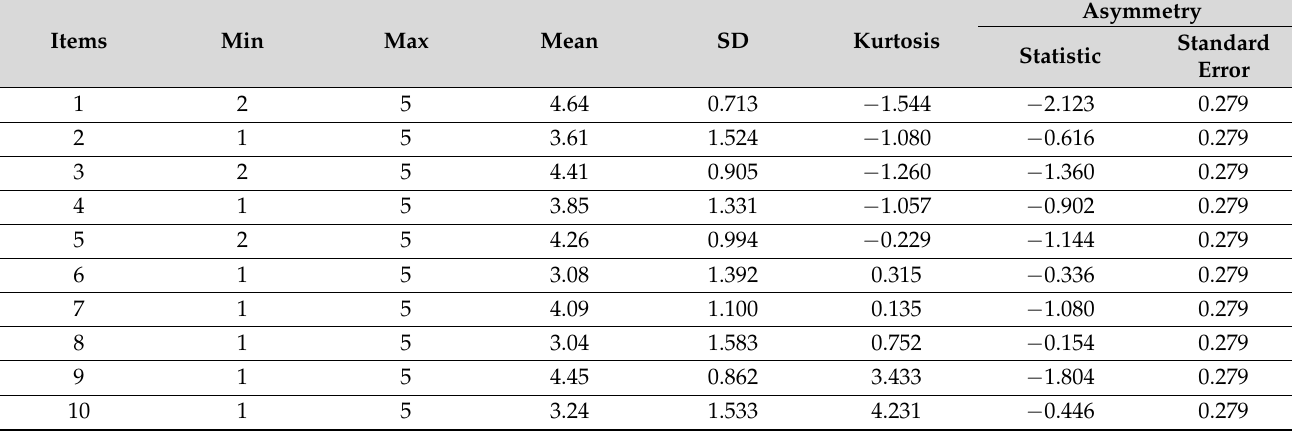
Table 1. Statistic parameters SUS analysis.